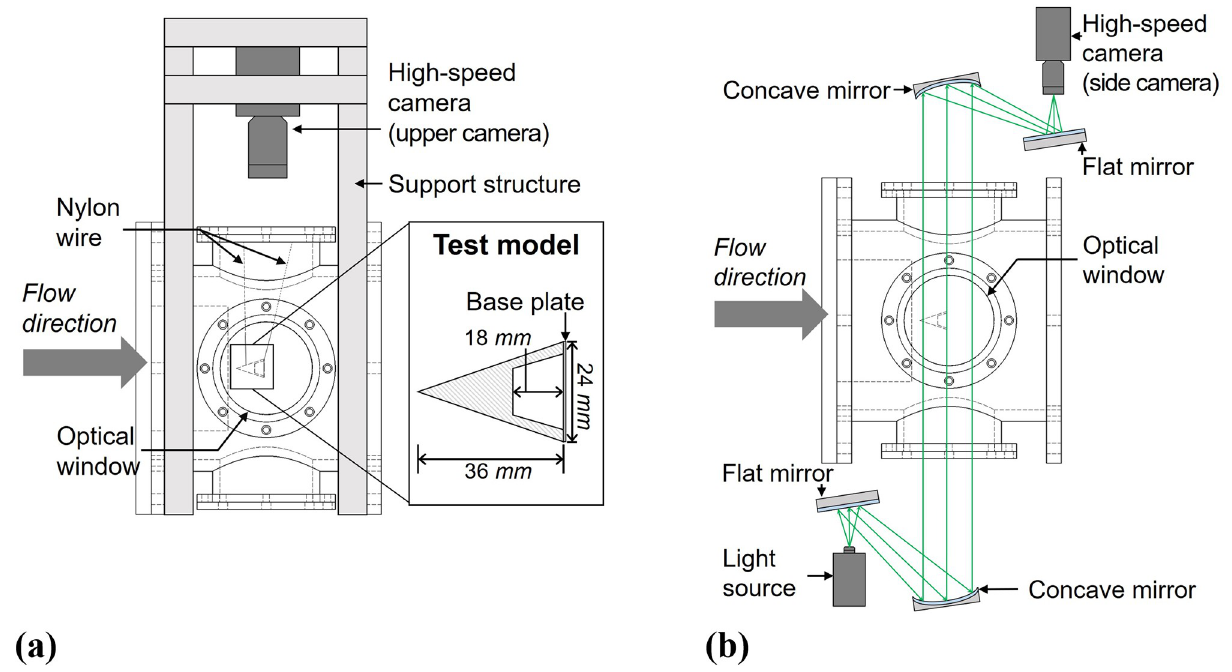
Fig 3. Schematic of the FFT setup. (a) Side view, (b) Top